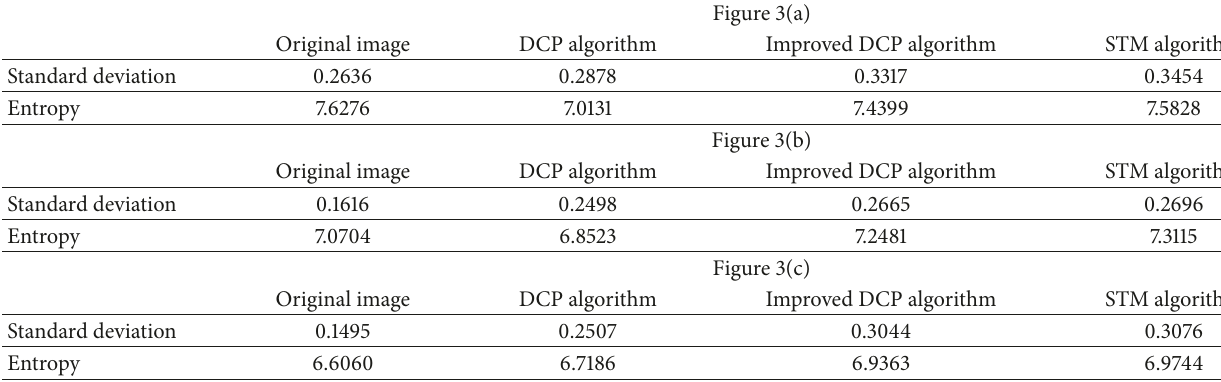
Table 1: Comparison of clearness images